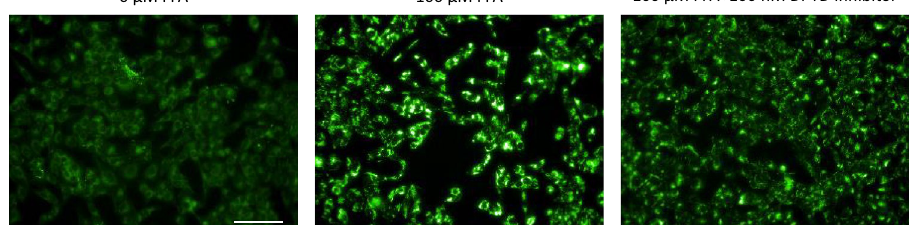
Figure 6. Selection of SNU449 cell line for modeling DPYD gain and loss of function mutations. ( A ) Digital droplet PCR was performed to assess the relative expression levels of UPP1 and DPYD normalized as a percentage of the geometric mean of GAPDH, UBC and RSP20. The ratio of their normalized expression was calculated and compared to primary human hepatocytes (PHH). The relative ratio of UPP1:DPYD in PHH (BioIVT lot WWQ) was 1.1, which was most closely represented by the SNU449 line with a ratio of 1.0. ( B ) LipidTox signal intensity increased with 100 µM free fatty acid exposure. DPYD inhibition decreased the LipidTox spot area per cell area in a dose responsive manner (IC50 of 19.74 nM and R 2 of 0.865) suggesting DPYD inhibition is protective against free fatty acid-induced neutral lipid accumulation in SNU449 cell line. ( C ) Representative images of SNU449 cell line treated with fatty acids in the presence and absence of 100 nM DPYD inhibitor demonstrate a significant increase in lipid accumulation (represented by the LipidTox stain) with FFA treatment that is further reduced in the presence of 100 nM DPYD inhibitor. Scale bar represents 100